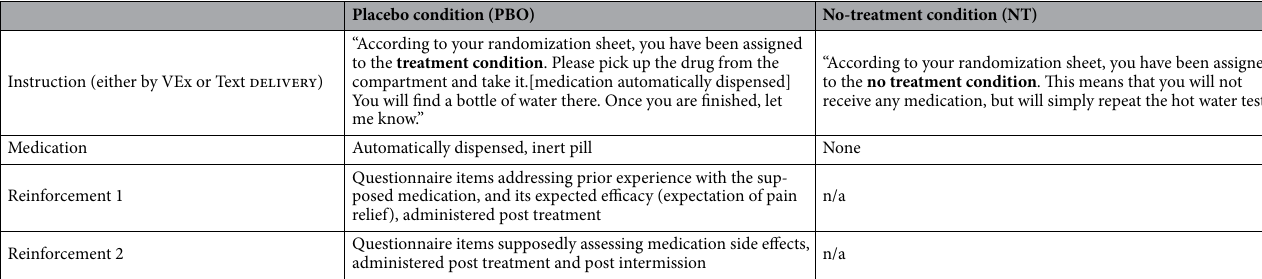
Table 1. Protocol differences between placebo and no-treatment Expectancy. Beyond the core manipulation (inert medication versus no medication), instructions differed between groups, and the placebo group’s expectancies were reinforced on two